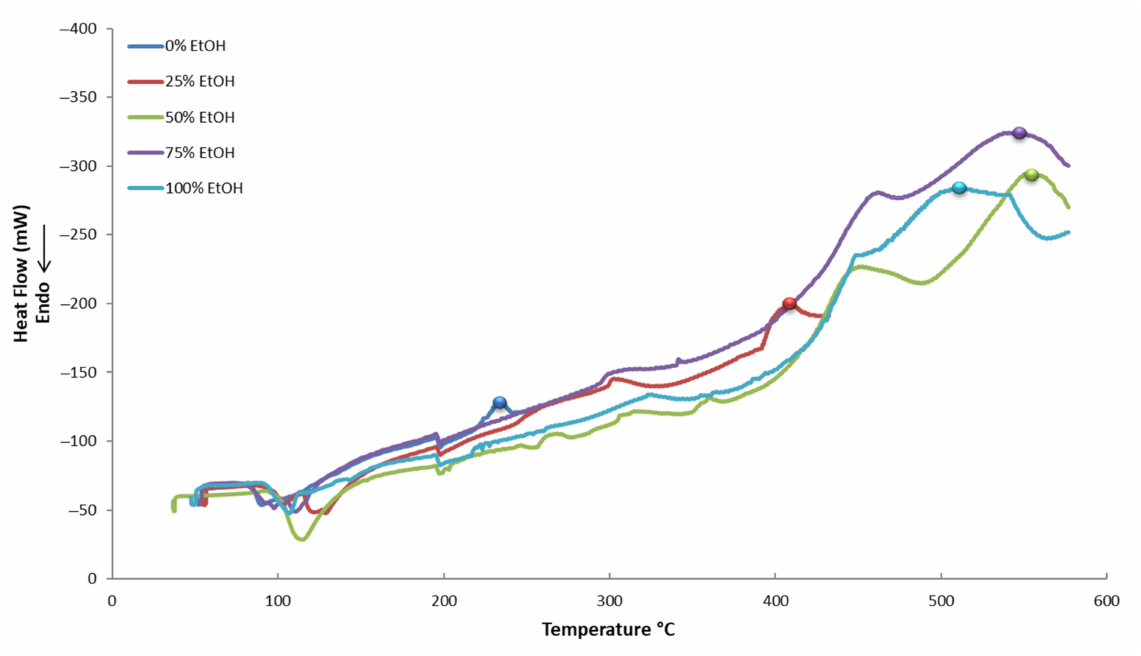
Figure 5. Differential scanning calorimetry (DSC) thermograms of control samples (no PEF applied) in five different tested solvents.